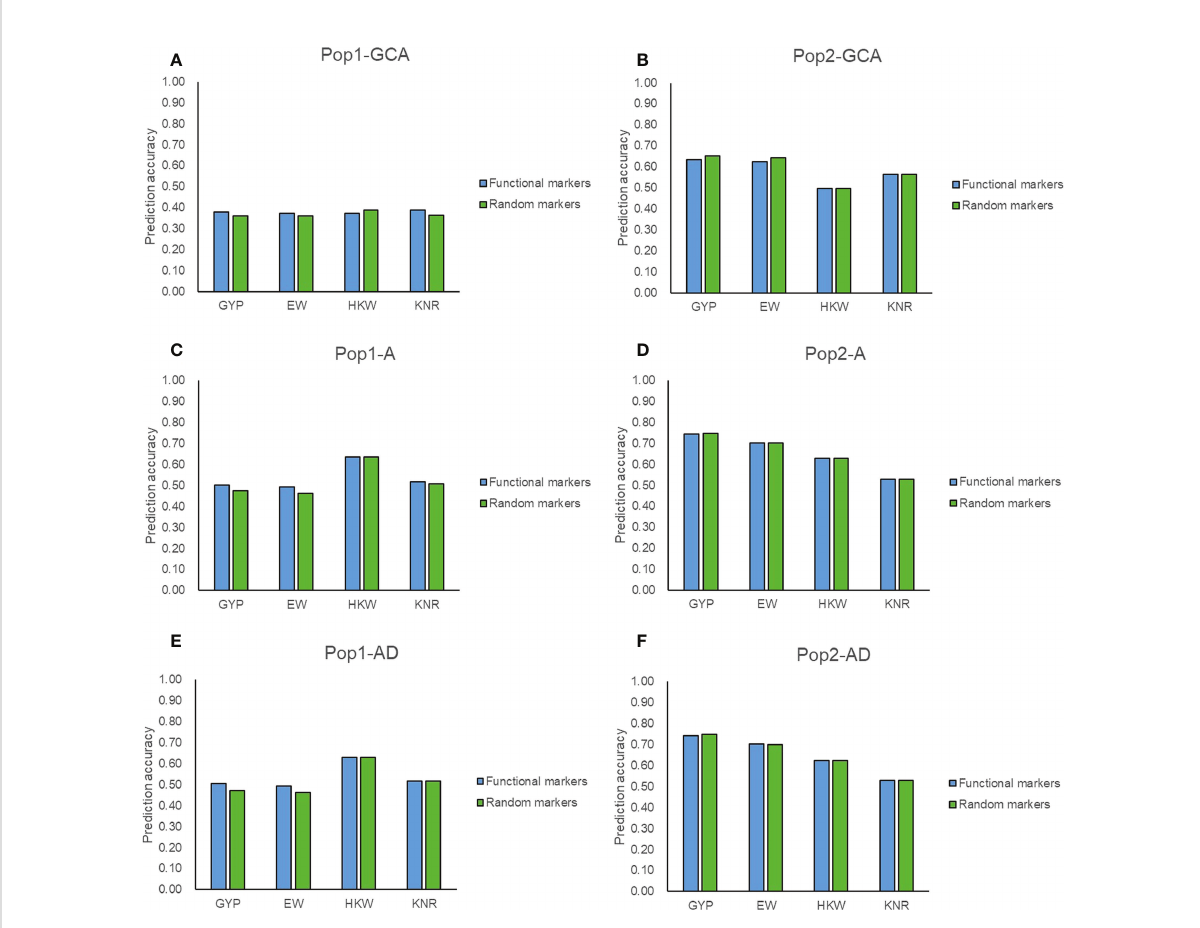
FIGURE 5 Accuracy of target SNPs in two populations. (A, B) represent the general combining ability prediction using RKHS method in Pop1 and Pop2, respectively. (C, D) represent hybrid performance prediction using RKHS with additive model (A) in Pop1 and Pop2, respectively. (E, F) represent hybrid performance prediction using RKHS with additive-dominance model (AD) in Pop1 and Pop2, respectively. Functional markers represent 906 target SNPs associated with mid-parent heterosis, allele-speci fi c expression, known genes, and yield-related traits. Random markers represent 906 target SNPs which are randomly selected from 1,115 target